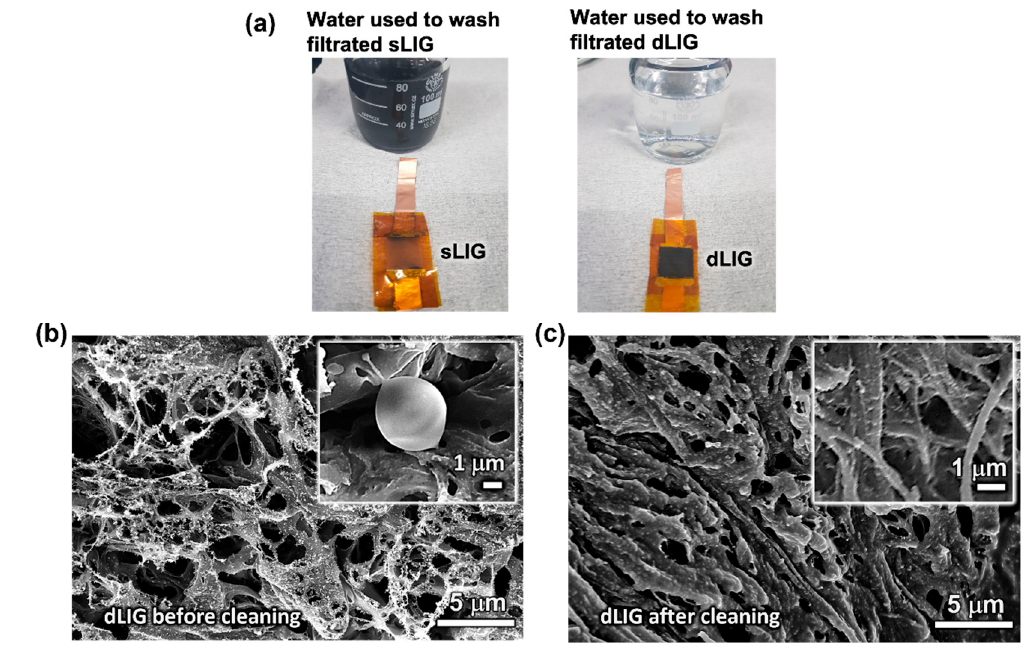
Figure 6. ( a ) sLIG filter and dLIG filter after cleaning with water, ( b ) Top-down view of dLIG filter after filtration, and ( c ) Top-down view of dLIG filter after washing captured via FE-SEM.